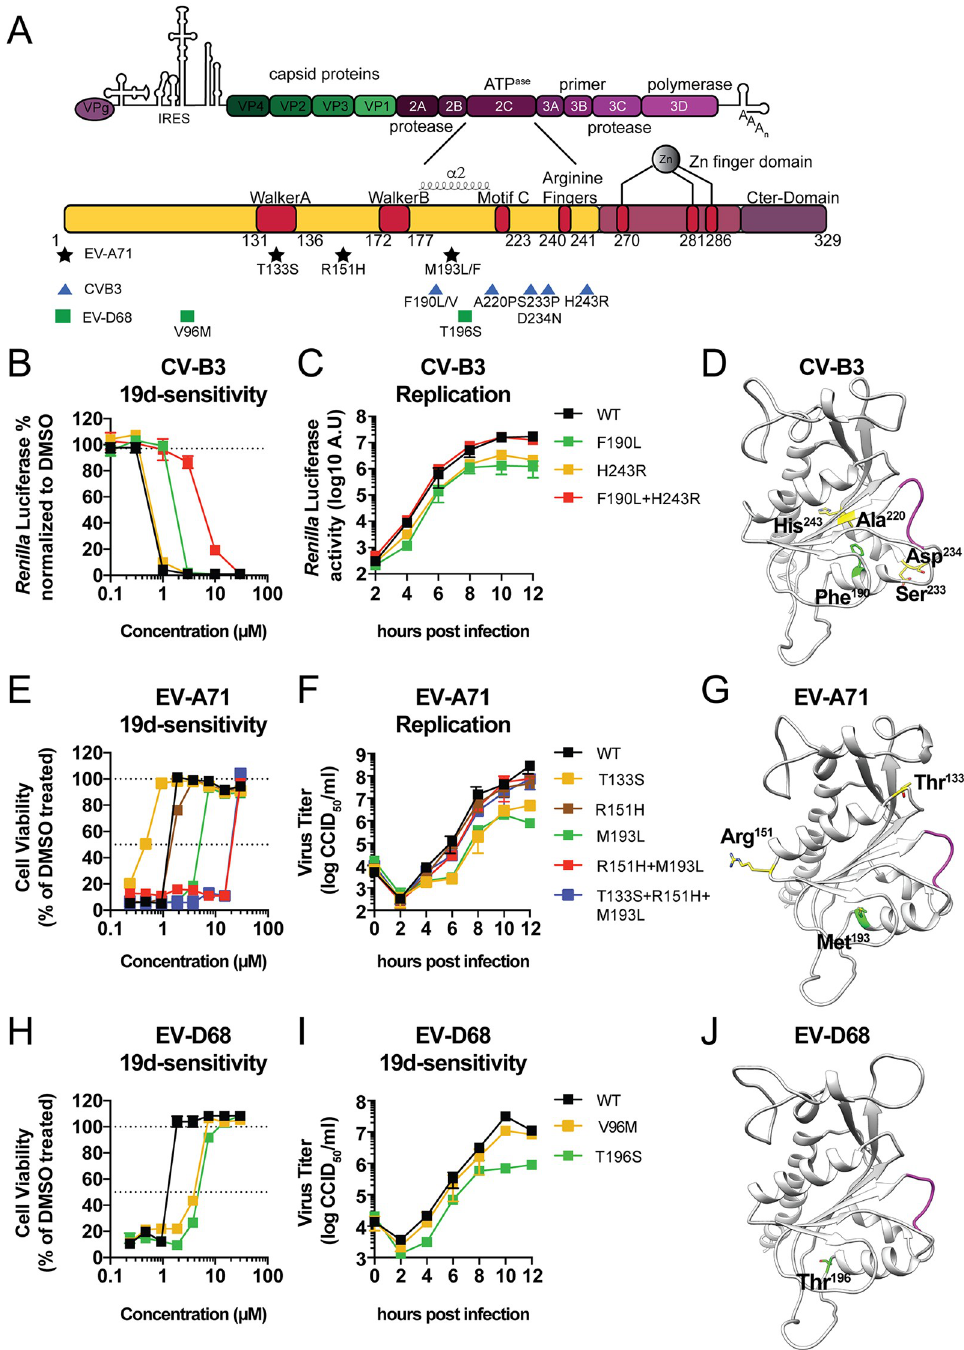
Fig 4. Effect of reverse-engineered 2C mutations on 19d sensitivity and replication fitness. (A) Schematic representation of the viral genome with a focus on the 2C protein and the functional domains. The resistance mutations for EV-A71 are highlighted with black stars, CV-B3 resistance mutations are depicted in blue triangles, and EV-D68 resistance mutations in green squares. (B) Single-cycle viral replication assay to determine 19d sensitivity of Rluc-CV-B3 reporter viruses harboring 2C mutations. HeLa R19 cells were infected with MOI 0.1 of RLuc-CV-B3 reporter virus and treated with serial dilutions of 19d. Rluc activity was determined at 8 hours post infection as a quantitative measure of replication. (C) Replication of Rluc-CV-B3 2C mutant viruses. HeLa R19 cells were infected at MOI 0.1 with the RLuc- CV-B3 viruses, and at the indicated time points, the cells were lysed and luciferase activity was determined. (D) The 2C mutations of CV-B3 2C which were acquired during resistance selection are mapped onto the previously